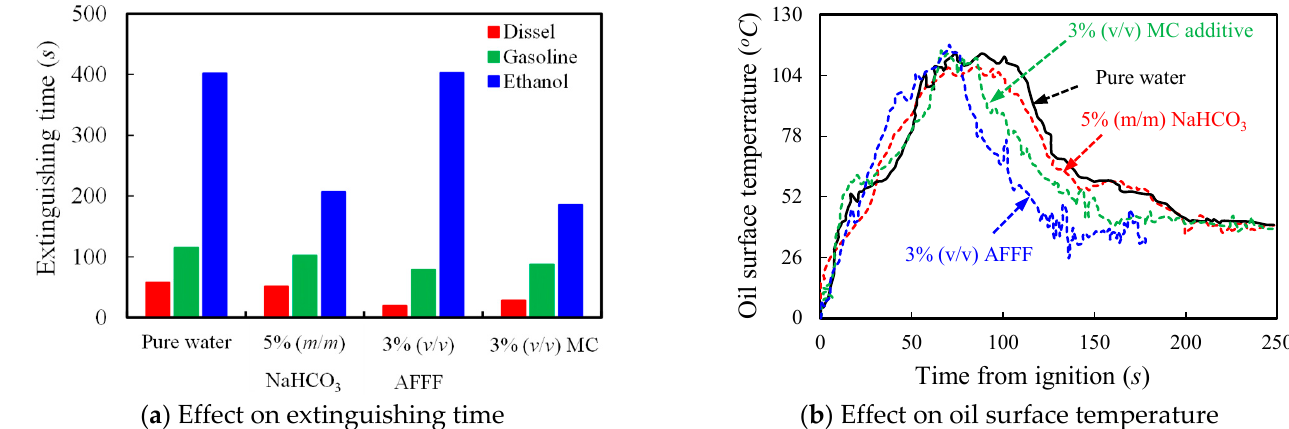
Figure 9. Liquid pool fires suppressed by water mist with additives [18].